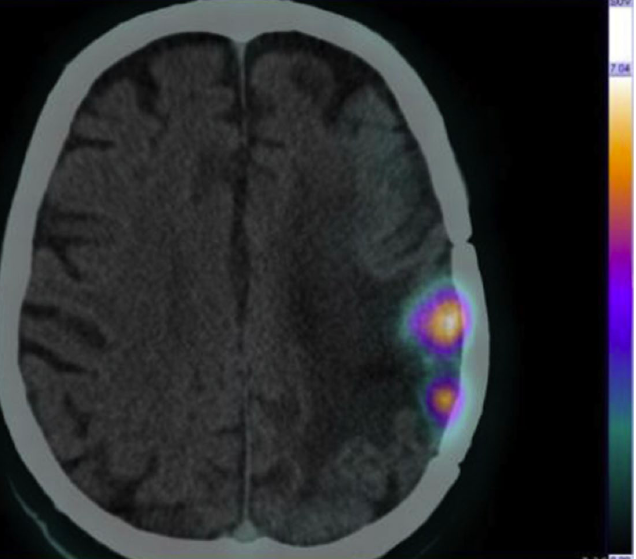
Figure 3. Brain 64 CuCl 2 PET/CT scan of a cerebral glioblastoma collected at 1 h post injection (injected activity, 13 MBq/kg). Adapted from ref 26 with permission of Panichelli P et al. Imaging of brain tumors with copper-64 chloride: Early experience and results. Cancer Biother. Radiopharm. 2016 , 31 , 159–167.